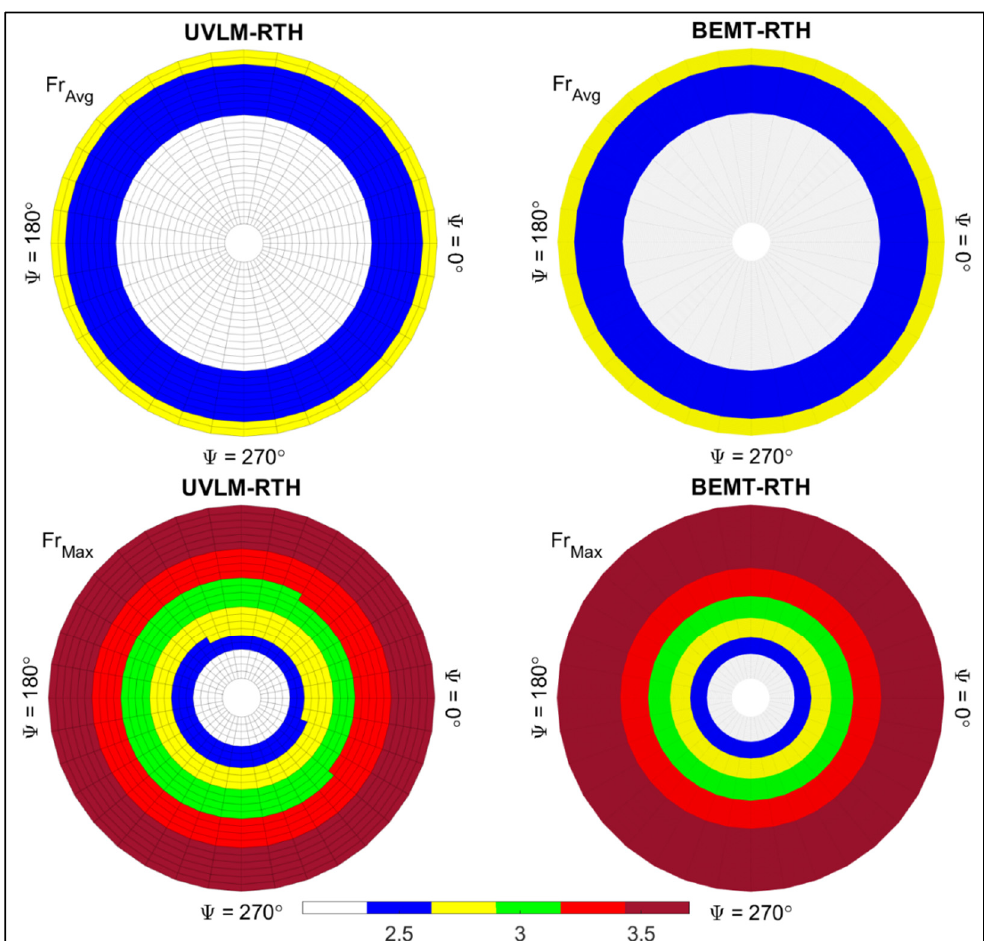
Figure 15. Contours of steady state Fr Avg and Fr Max for the hovering modified Bell 429 tail rotor obtained using BEMT-RHT and UVLM-RHT.